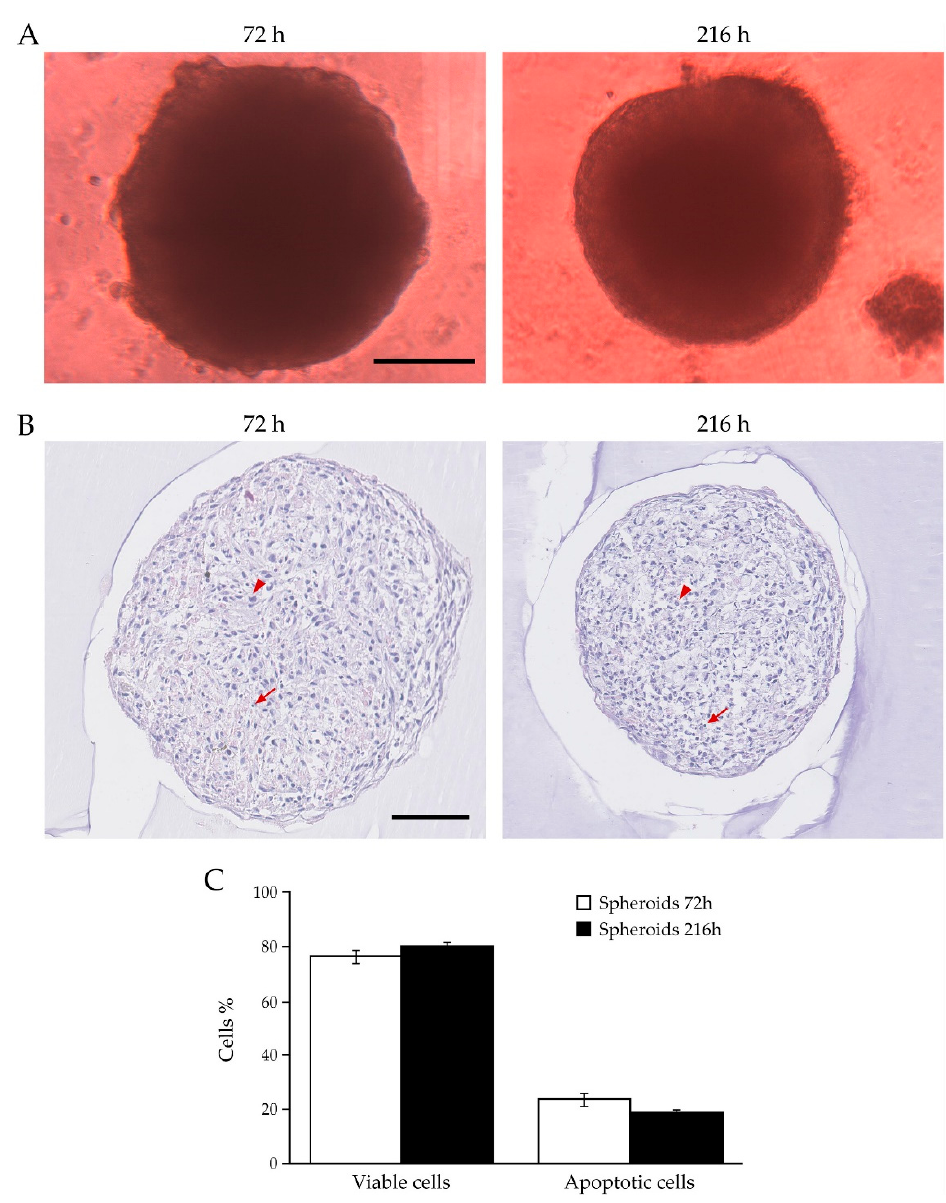
Figure 4. Analysis of BCAFs grown as spheroids. ( A ) Representative images of BCAF spheroids at 72 h and 216 h by phase-contrast microscopy. Scale bar 200 µ m. Magnification × 10. Volumes of spheroids collected at 72 and 216 h were 0.109 mm 3 ± 0.0075 and 0.0864 ± 0.0057, respectively. Data are reported as means of at least three independent experiments ± S.E. p < 0.05. ( B ) Hematoxylin and eosin staining of paraffin-embedded sections of BCAF spheroids collected at 72 and 216 h of 3D cell culture. Arrowheads indicate viable cells, while arrows indicate apoptotic cells. Scale bar 100 µ m. Magnification × 20. ( C ) Live and apoptotic cell graph of spheroids collected at 72 h and 216